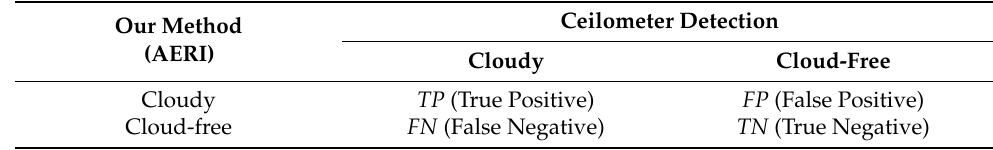
Table 4. 2 × 2 confusion matrix of the comparison between our method and the ceilometer detection method. In this table, TP is the number of the events that the ceilometer reports cloudy and AERI reports cloudy. FP is the number of the events that ceilometer reports cloud-free but AERI reports cloudy. FN is the number of the events that ceilometer reports cloudy but AERI reports cloud-free. TN is the number of the events that ceilometer reports cloud-free and AERI reports